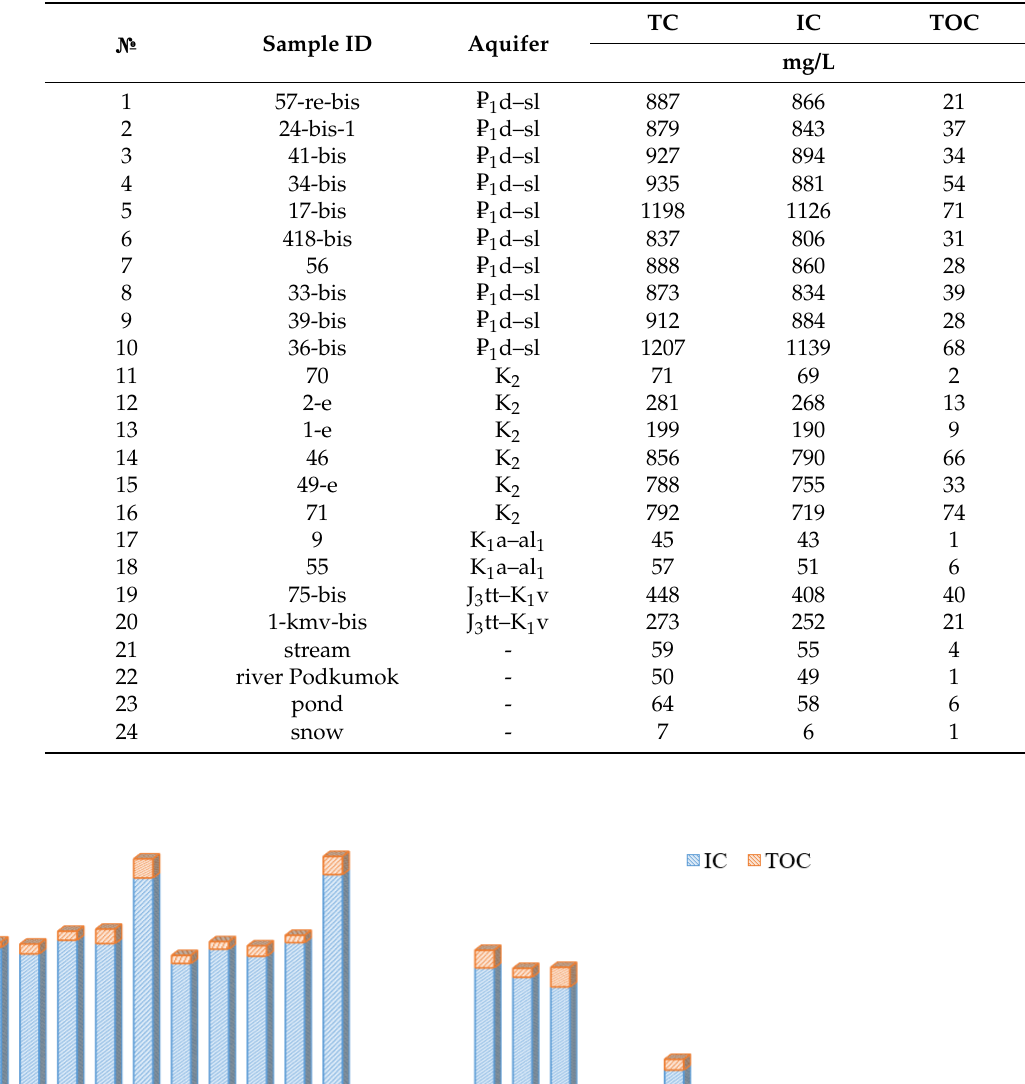
Table 1. Characteristics of the studied water samples.